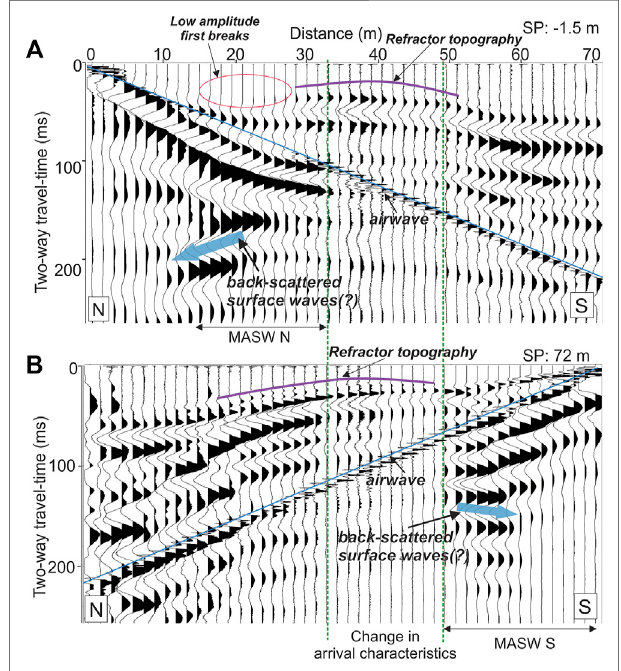
FIGURE 9 | First 250 ms TWT of seismic gathers acquired at the Hummocky Site, displayed in positive standard polarity. Strong airwave components and potential back-scattered surface waves are highlighted and geophoneoffsetsusedinMASWanalysisde fi ned.Verticaldashedgreen lines mark the offsets at which a change in arrival characteristics occurs. (A) Forward shot taken at shotpoint S − 1.5. (B) Reverse shot taken at shotpoint S